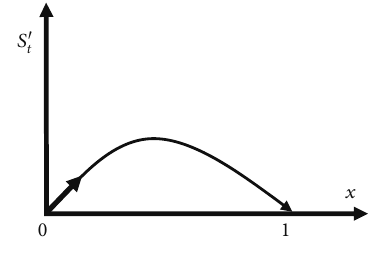
Figure 1: Bank selects the credit strategy.